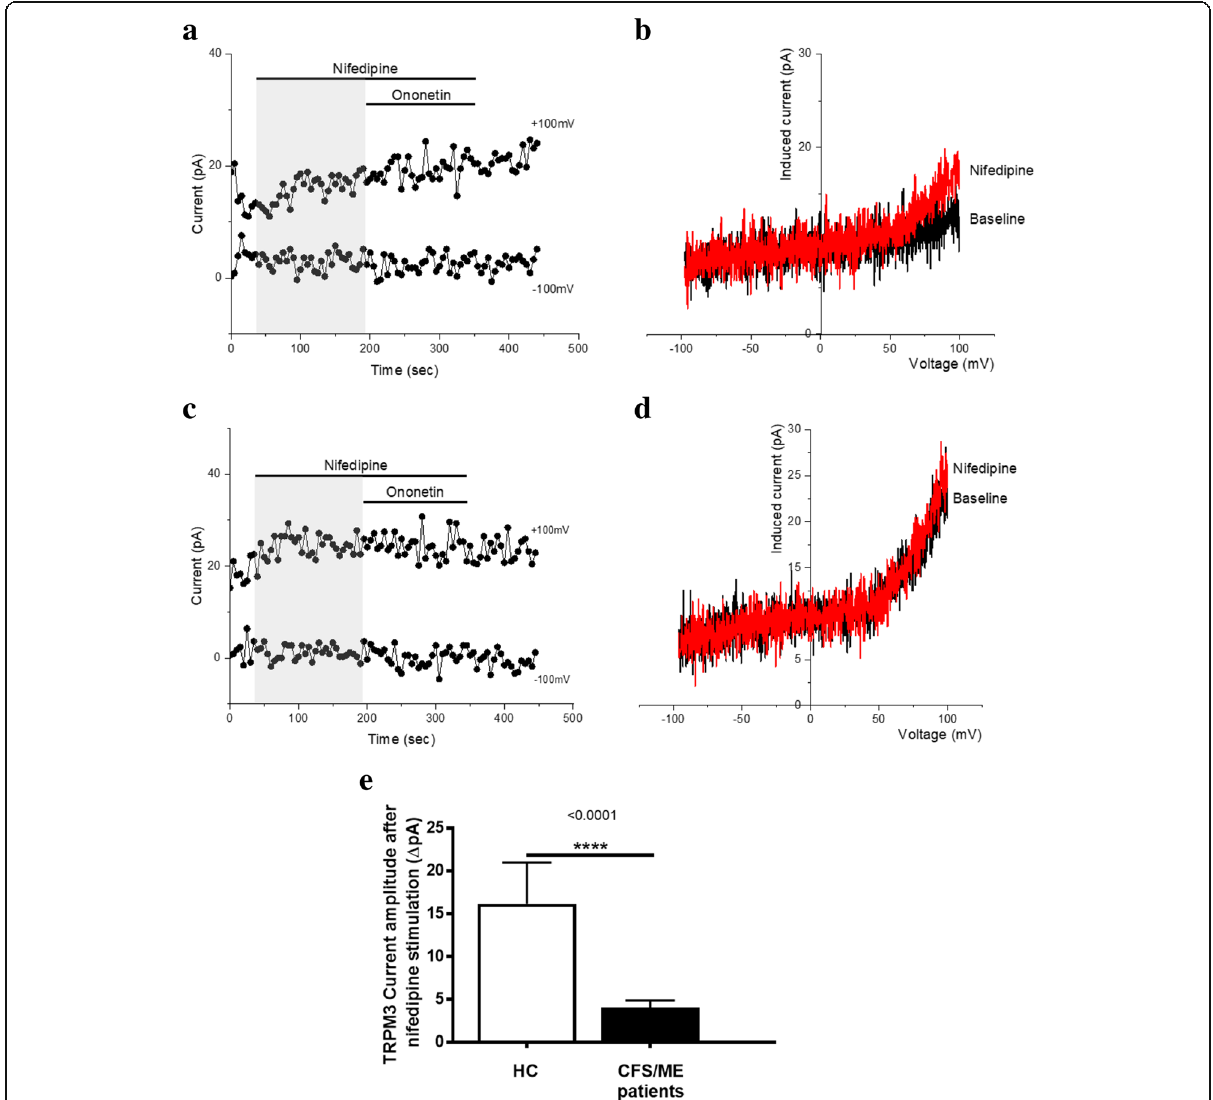
Fig. 4 TRPM3 activity after stimulation with nifedipine alone. Data were obtained under whole-cell patch clamp conditions. a. A representative time-series of current amplitude at + 100 mV and − 100 mV showing the effect of 100 μΜ nifedipine on ionic currents in isolated NK cells from HC. b. I – V before and after nifedipine stimulation in a cell corresponding with ( a .) . c. A representative time-series of current amplitude at + 100 mV and − 100 mV showing the effect of 100 μΜ nifedipine on ionic currents in isolated NK cells from CFS/ME patients. d. I – V before and after nifedipine stimulation in a cell as shown in ( c .) . e Bar graphs representing TRPM3 current amplitude at + 100 mV after stimulation with 100 μΜ nifedipine in CFS/ME patients ( N =6; n =25) compared with HC (N=6; n =23). Data are represented as mean±SEM. Abbreviations: CFS/ME, chronic fatigue syndrome/myalgic encephalomyelitis; HC, healthy controls ; NK, natural killer; PregS, Pregnenolone sulfate; TRPM3, Transient Receptor Potential Melastatin